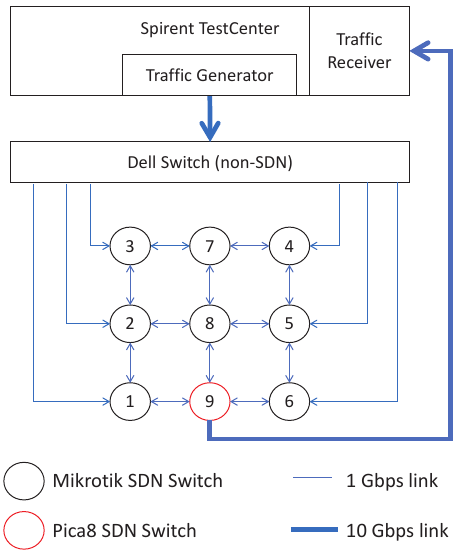
Figure 3. The topology of the testbed.